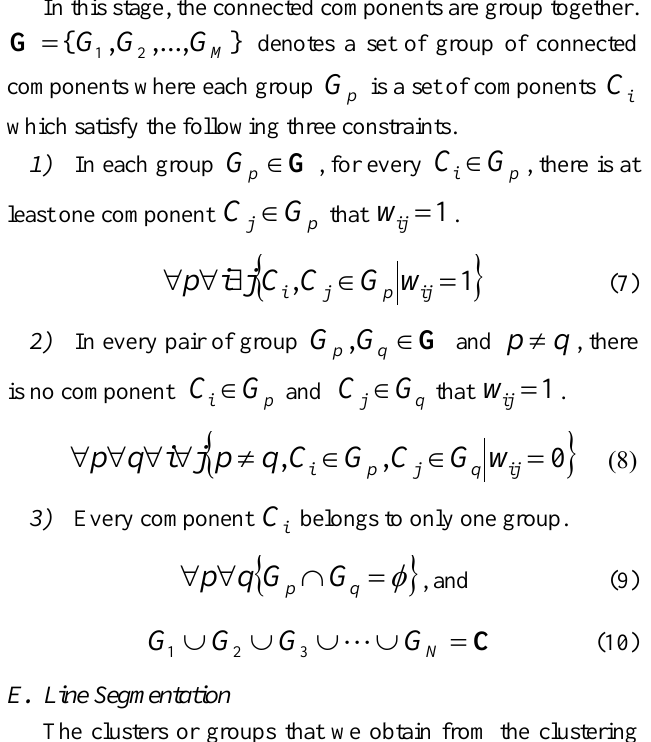
Figure 7. Exmples of extent and solidity in groups of MSER